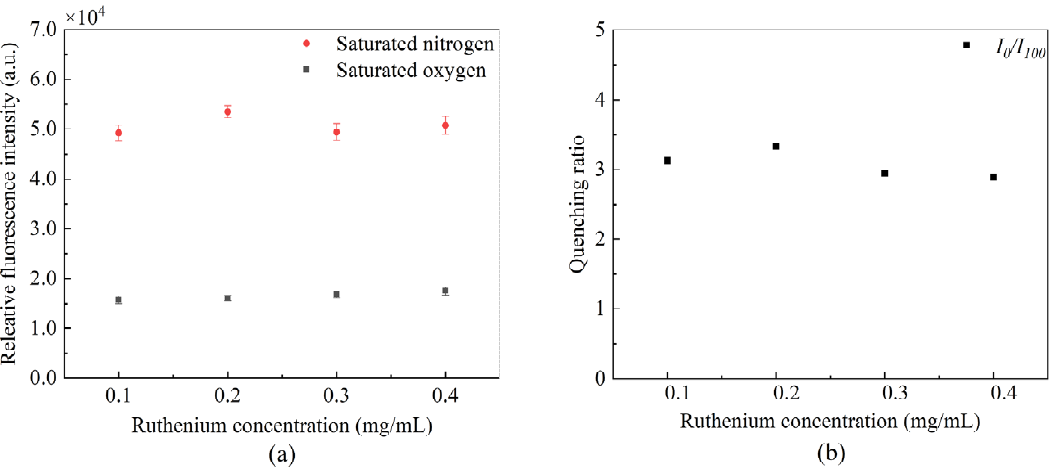
Figure 4. Fluorescence of ruthenium with different concentrations ( a ) fluctuation of fluorescence peak intensity, and ( b ) influence of quenching ratio.